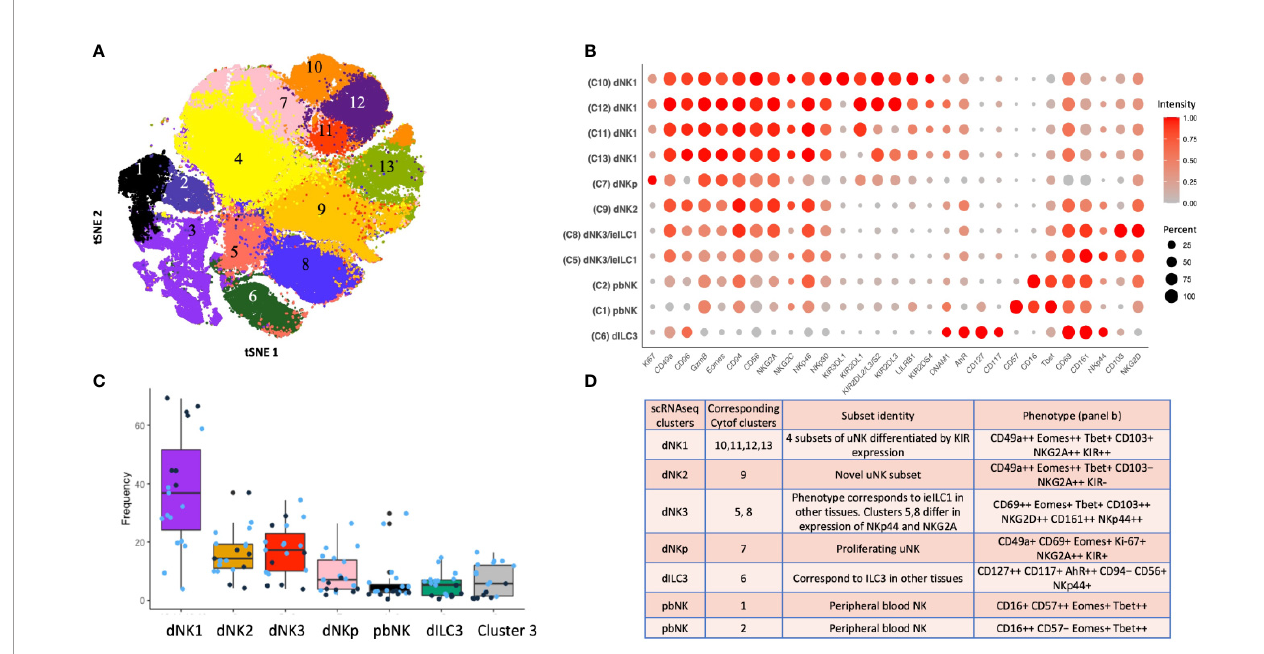
FIGURE 4 | ILC subsets identi fi ed by mass cytometry of fi rst trimester decidual cells. (A) tSNE landscape of CD45+ CD3- CD19- CD14- HLA-DR- (Lin-) cryopreserved decidual cells stained by mass cytometry. tSNE is coloured by clusters identi fi ed by DensVM clustering. 11 of these clusters can be assigned to NK or ILC subsets. Cluster 3 is heterogeneous and cluster 4 appears to contain cells damaged by cryopreservation so these were excluded from subsequent analysis. (B) Phenotypic characterisation of selected clusters. Size of the circle is representative of the proportion of the cluster positive for that marker. Circles are coloured by intensity of staining for that marker. Intensities have been scaled by marker (ie within each column). Red corresponds to higher expression and grey to lower expression. Percentage of cells in the cluster staining for each marker is indicated by size of the circles, scaled as shown on the right of the fi gure. (C) Box plots show the proportions of designated clusters within the total CD45+ Lin- decidual compartment. Blue dots = cryopreserved samples, Black dots = fresh samples. [ Figure 4A adapted from Huhn et al. (39), where details of the antibody panel are described]. (D) Comparison of decidual NK and ILC clusters identi fi ed by single cell RNA sequencing (scRNAseq) (40) and by mass cytometry (Cytof) (39). Identity of each cluster is based on their pro fi les of RNA or protein marker expression respectively. Cytof clusters 10-13, correspond to scRNAseq cluster dNK1 and are distinguished by their KIR expression. Cytof clusters 5,8 are distinguished by NKp44/ NKG2A expression and correspond to scRNAseq cluster dNK3, representing ieILC. Cytof clusters 3 and 4 identi fi ed in panel A appear heterogeneous and don ’ t match any scRNAseq clusters; identities are not established. ++ is > 75% positive staining of cells with antibody in Cytof; + is 25% to 75%; − is